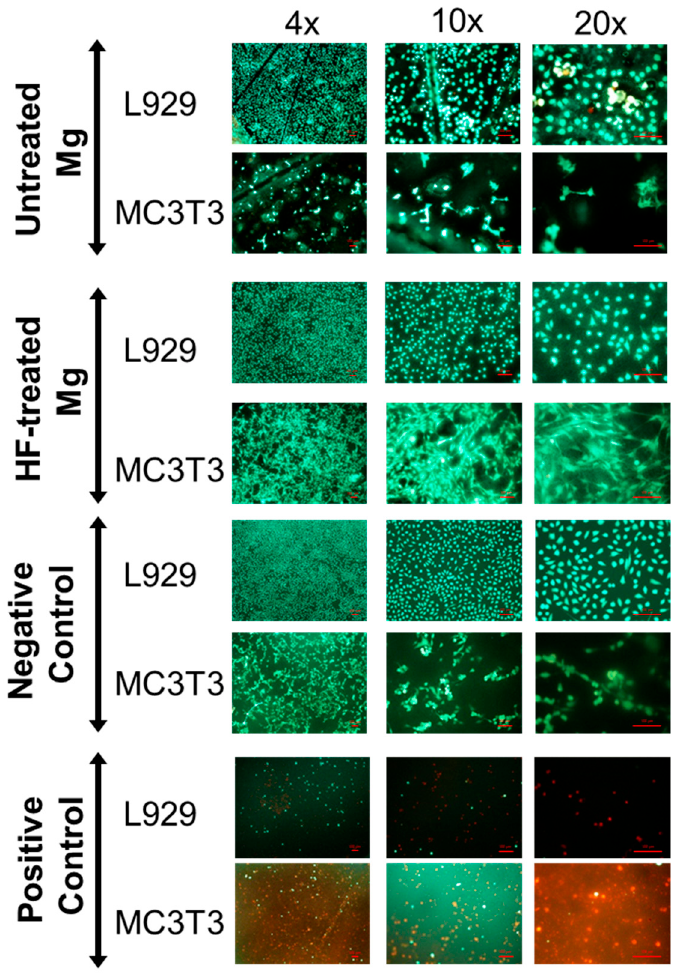
Figure 5. Attachment of cells on surfaces of the different variants and controls. The pictures show the attachment, vitality and morphology of the cells. Green: vital cells; red: dead cells. Spindle-shaped morphology indicates healthy cells with firm attachment. Round cells indicate poor attachment onto the surface.